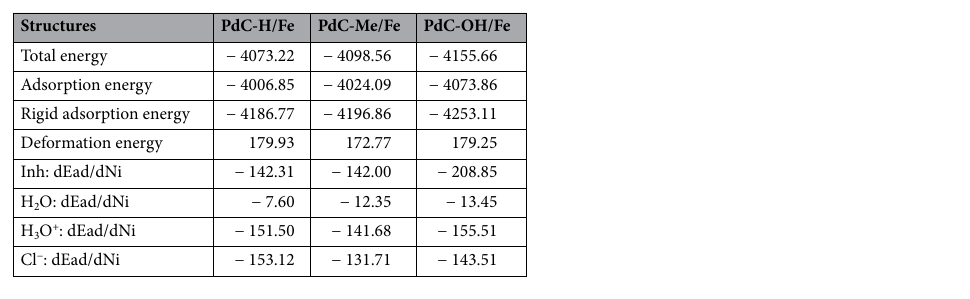
Table 11. List of Monte Carlo simulations parameters of compounds on